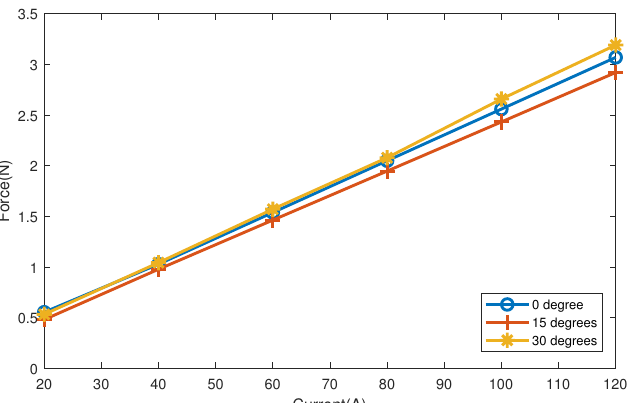
Figure 9. Influence of pitch angle of suspension model on relation curve of current and electromag- netic